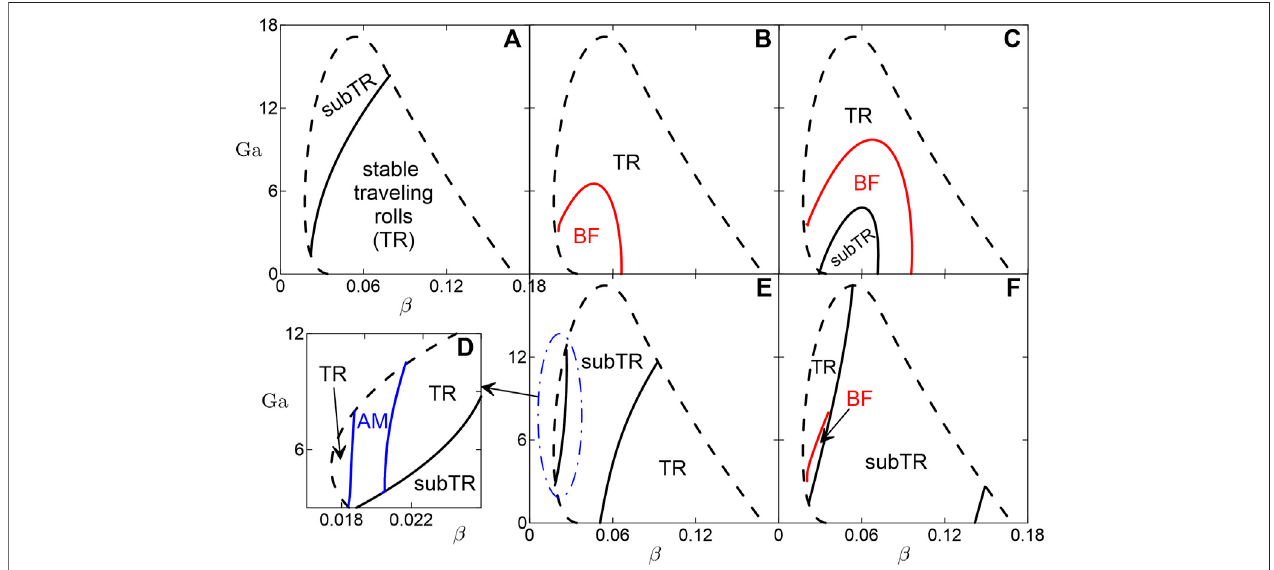
FIGURE 2 | Domains of stability for traveling rolls against the longitudinal modulations for (A) uncontrolled convection; (B,C) negative non-linear feedback control gain 8 q (cid:1) − 0 . 2 , − 0 . 3; (E,F) positive non-linear feedback control gain 8 q (cid:1) 0 . 1 , 0 . 3. (D) Zoomed-in fragment of the panel (E) . Dashed lines indicate the area of the oscillatory convection. Within domains marked “ subTR, ” traveling rolls bifurcate subcritically. “ TR ” marks domains of stability for traveling rolls. Benjamin – Feir instability and the amplitude modulational instability occur within domains marked “ BF ” and “ AM, ”